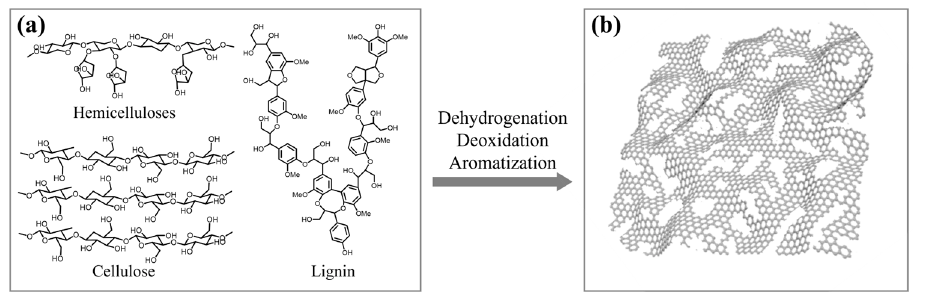
Figure 1. Dehydrogenation, deoxygenation, and graphitization of biomass. ( a ) The chemical structures of hemicelluloses, cellulose, and lignin; ( b ) the actual two-dimensional plane structure of biochar with defects.